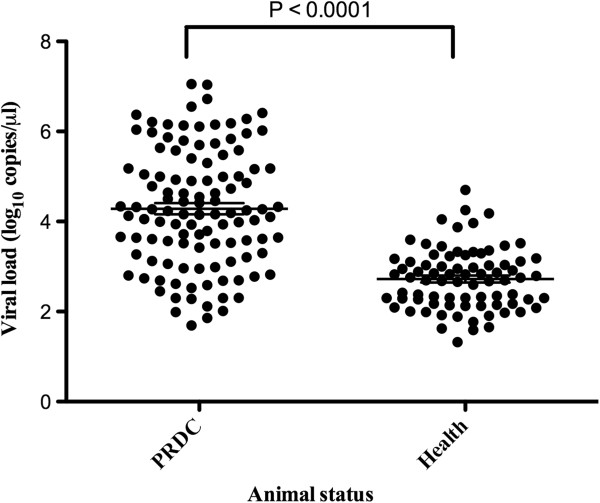
Absolute copy number per microliter of PRRSV in serum from PRDC and clinically asymptomatic pigs. The serum of PRDC (n = 112) and asymptomatic pigs (n = 79) was analyzed using ZNA probe-based real-time PCR. The mean percentages (long horizontal lines) of the PRRSV load in the PRDC and asymptomatic pigs were compared. Error bars show SD. The PRRSV load was significantly higher (P < 0.0001) in the pigs with PRDC compared with the asymptomatic pigs, as assessed by unpaired, 2-tailed Student’s t-tests.